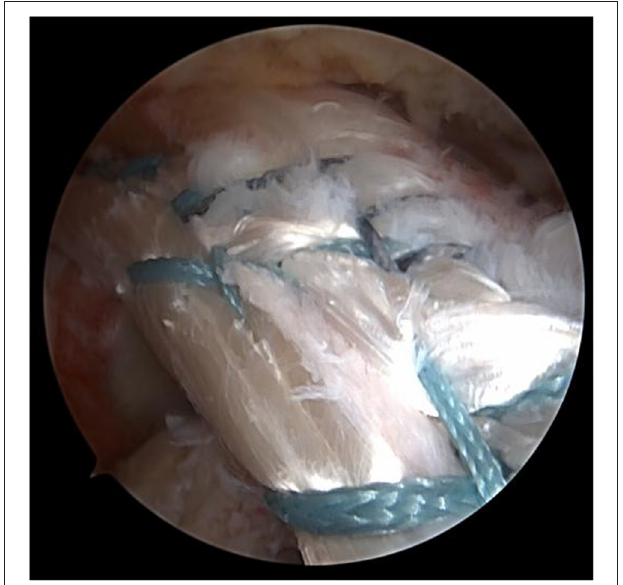
FIGURE 5 | The loop end of the tendon autograft was tied to the anchor fixating the biceps tendon by the suture left from the last step.